Question: Sum up the contents of this chart in one sentence.
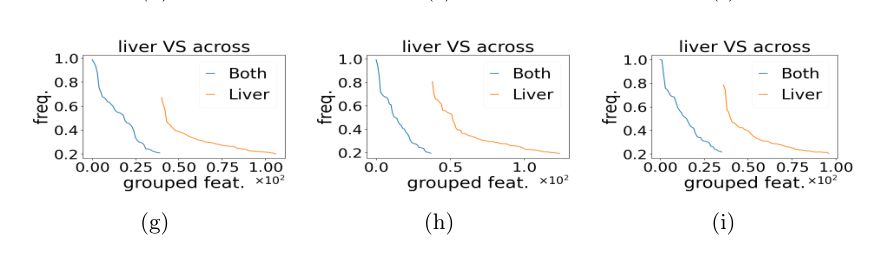
Answer: Grouped by overlapping distribution of features for all experiments. Columns are associated with experiments, i.e. 1st - tolerant versus susceptible, 2nd - resistant versus susceptible, 3rd - infected versus never infected. (a),(b),(c) distributions of fea- tures extracted in across domains experiments; (d),(e),(f) features extracted in sepa- rate spleen experiment, features are grouped by overlapping with features extracted in respective across domains experiment: "Both" - overlapping, "Spleen" - not overlap- ping; (g),(h),(i) features extracted in separate liver experiment, features are grouped by overlapping with features extracted in respective across domains experiment: "Both" - overlapping, "Liver" - not overlapping.